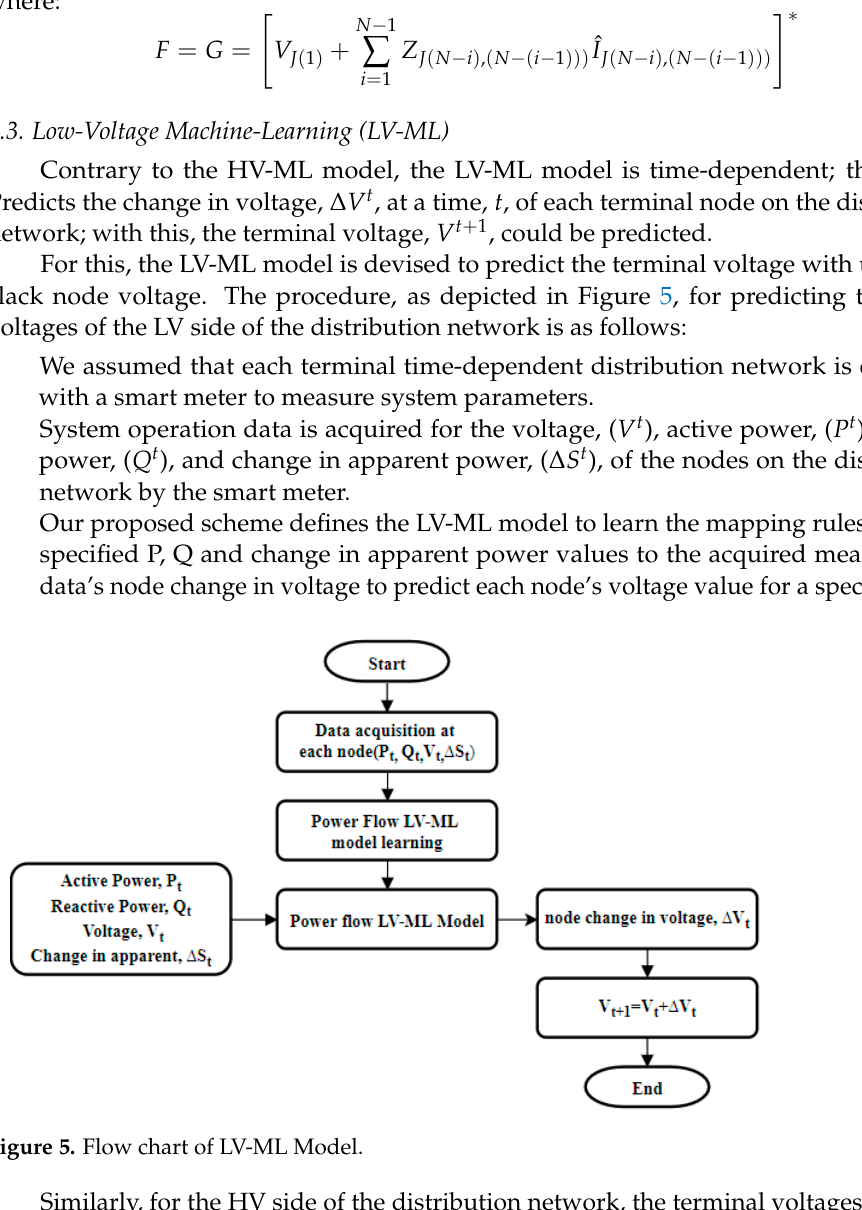
Figure 6. Simplified Linear Low-Voltage Distribution network topology . The voltage, 𝑉(cid:3552) (cid:3047)(cid:2878)(cid:2869) , of the terminal load could be expressed in terms of its proceeding voltage, 𝑉 (cid:3047) , and the change in voltage, Δ𝑉(cid:3552) (cid:3047) , as specified in (22) Similarly, the apparent power, 𝑆 (cid:3047)(cid:2878)(cid:2869) , could be expressed as defined in (21). 𝑆 (cid:3021)(cid:3047)(cid:2878)(cid:2869) = 𝑆 (cid:3021)(cid:3047) + ∆𝑆 (cid:3021)(cid:3047) (21) 𝑉(cid:3552) (cid:3021)(cid:3047)(cid:2878)(cid:2869) = 𝑉 (cid:3021)(cid:3047) + ∆𝑉(cid:3552) (cid:3021)(cid:3047)